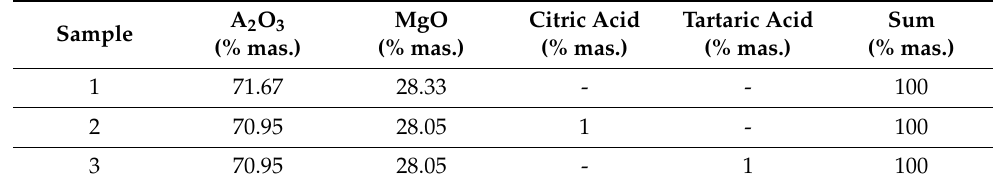
Figure 1. Raw materials used in the experiment: ( a ) alumina powder RG 4000; ( b ) magnesium oxide powder; ( c ) citric acid; and ( d ) tartaric acid. Table 1. Composition of the studied